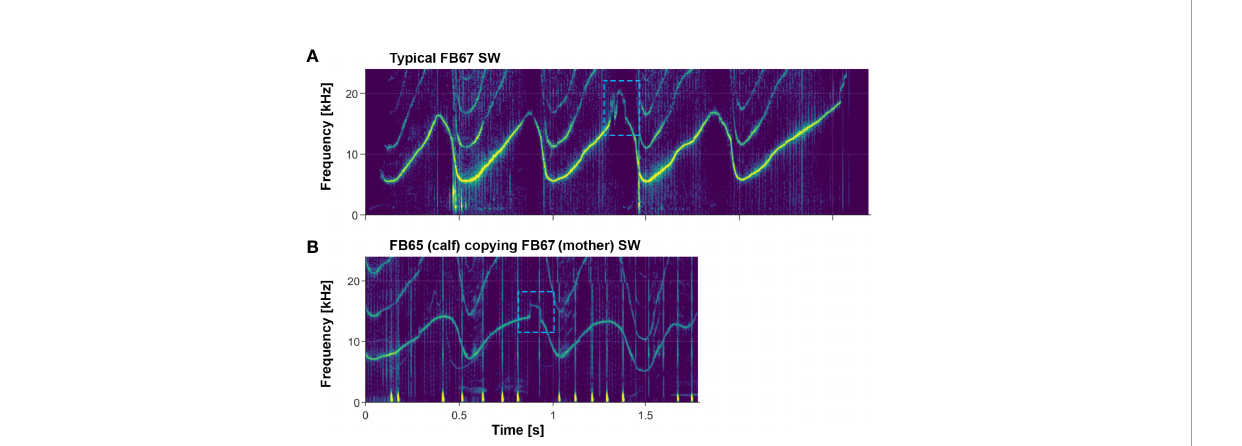
FIGURE 10 Example of a subtle whistle feature being preserved in a signature whistle copy. (A) Signature whistle of FB67, an adult female; she sometimes includes a subtle feature as seen in the 3 rd loop of her whistle (blue dashed box). (B) Copy of FB67 ’ s signature whistle emitted by her daughter FB65. Note the preservation of the subtle feature (blue dashed box) in the 2nd loop of the signature whistle copy. The faint whistle in the background is FB67 emitting her own whistle. Examples of FB65 ’ s own signature whistle can be seen in Figure